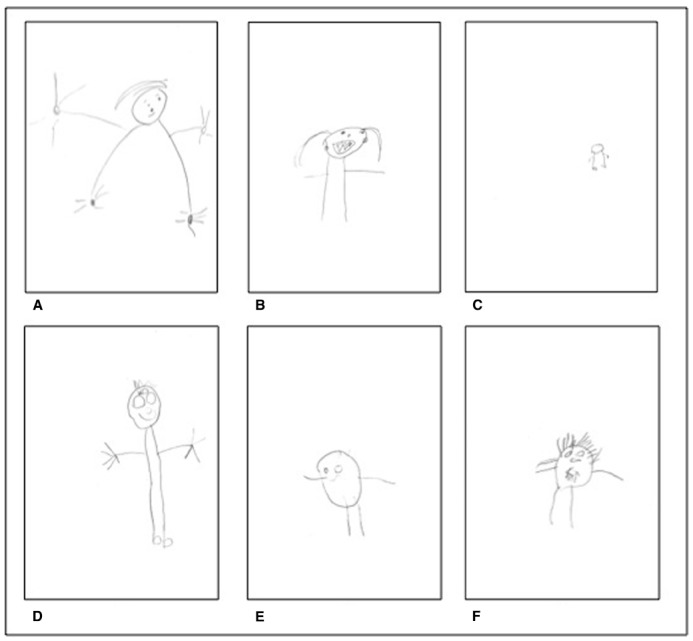
Examples of tadpole drawings across cultural groups. (A) Germany urban, boy, age: 4;0. (B) Turkey urban, girl, age: 4;1. (C) Cameroon rural, boy, age: 4;2. (D) Costa Rica urban, boy, age: 4;0. (E) Estland urban, girl, age: 4;1. (F) India rural, girl, age: 3;11.